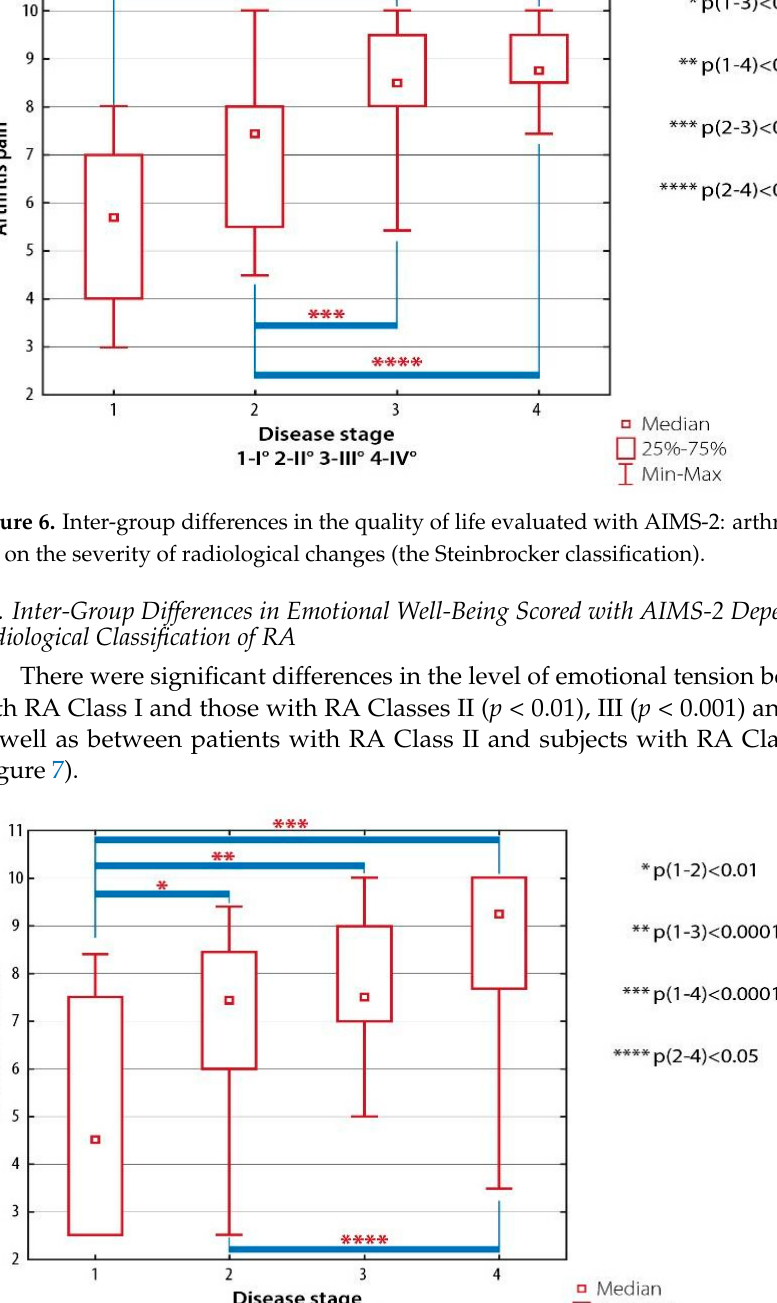
7 of 13 Figure 5. Inter-group differences in the quality of life evaluated with AIMS-2: household tasks, de- pending on the severity of radiological changes (the Steinbrocker classification).